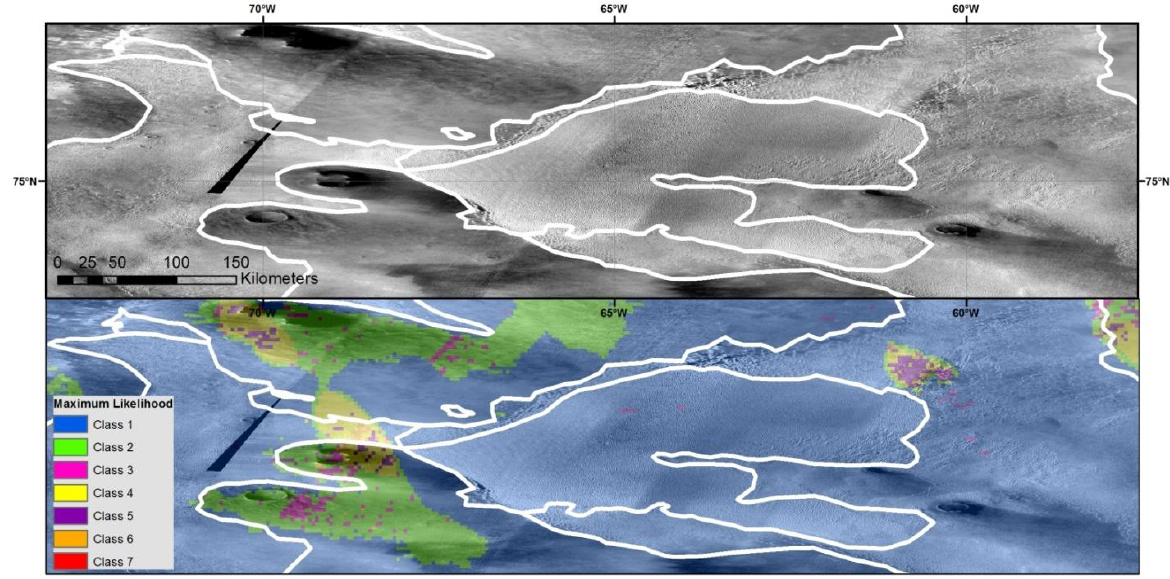
Figure 18. Dunes in the Olympia Undae dune field. ( Top ) image shows the dune field [167,168,174] outlined on top of the THEMIS daytime-IR basemap; ( Bottom ) image shows the thermophysical classes of Figure 13. Image credit: NASA Mars